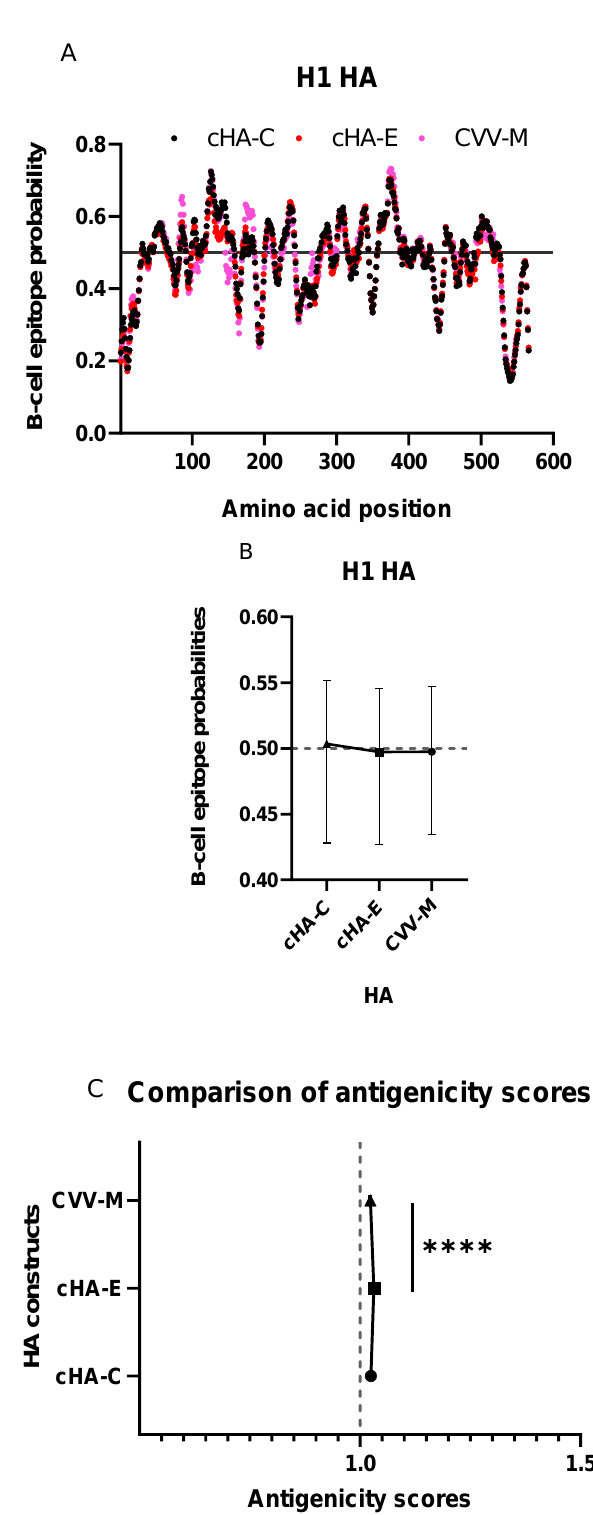
Figure 4. B-cell epitopes and antigenicity predictions on the H1 HAs. Here are charts describing B-cell epitope probabilities and antigenicity scores of the H1 HAs. ( A ) displays the distributions of the probable epitopes over the default threshold of 0.5; ( B ) represents the comparison of the medians of the B-cell epitope probability scores, using the Kruskal–Wallis test; ( C ) displays the antigenicity of the HAs given a default threshold of 1.000 antigenicity score: Means of the scores were compared using two-way ANOVA and p -values were corrected using Dunnett’s multiple comparisons test p < 0.0005: ****. Table 2. Unique and shared epitopes in the H1 HAs.